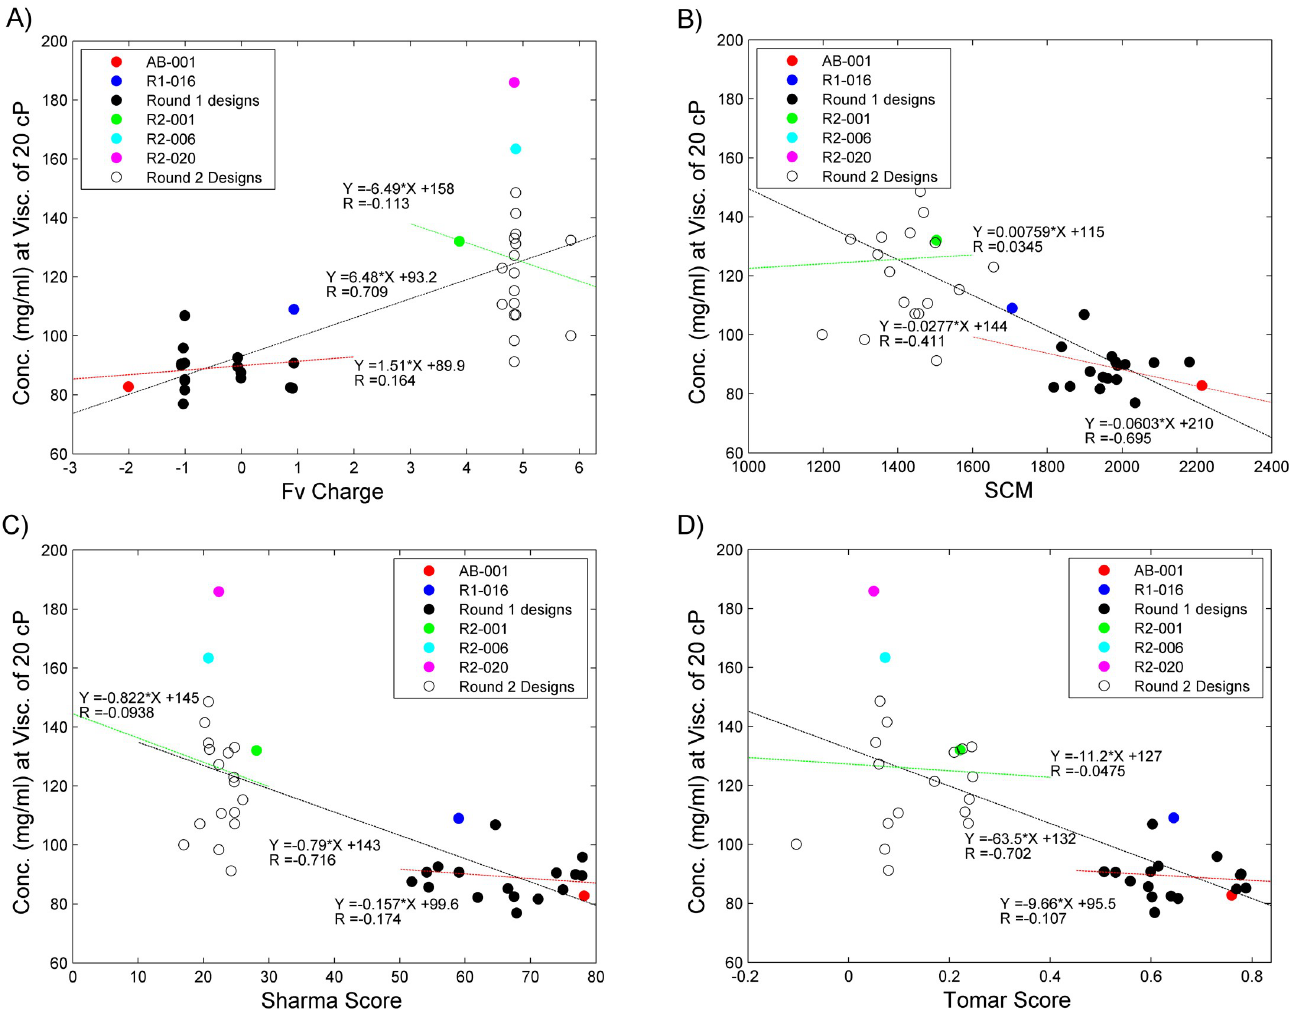
Fig 7. Analysis of charge-based prediction of viscosity. The concentrations where the viscosity reaches 20 cP of the round 1 and round 2 mutants are plotted against the (a) Fv-Charge, (b) SCM method, (c) Sharma Score and (d) Tomar Score. For each of these AB-001 is shown in red, R1-016 is in blue, the remaining round 1 designs in filled black circles, R2-001 in green, R2-006 in cyan, R2-020 in magenta and the remaining Round 2 designs are in empty black circles. The linear fit lines are shown on the charts along with the correlation value. Round 1 linear fit is shown as a red dashed line, Round 2 linear fit as a green dashed line and the overall linear fit is shown as a black dashed